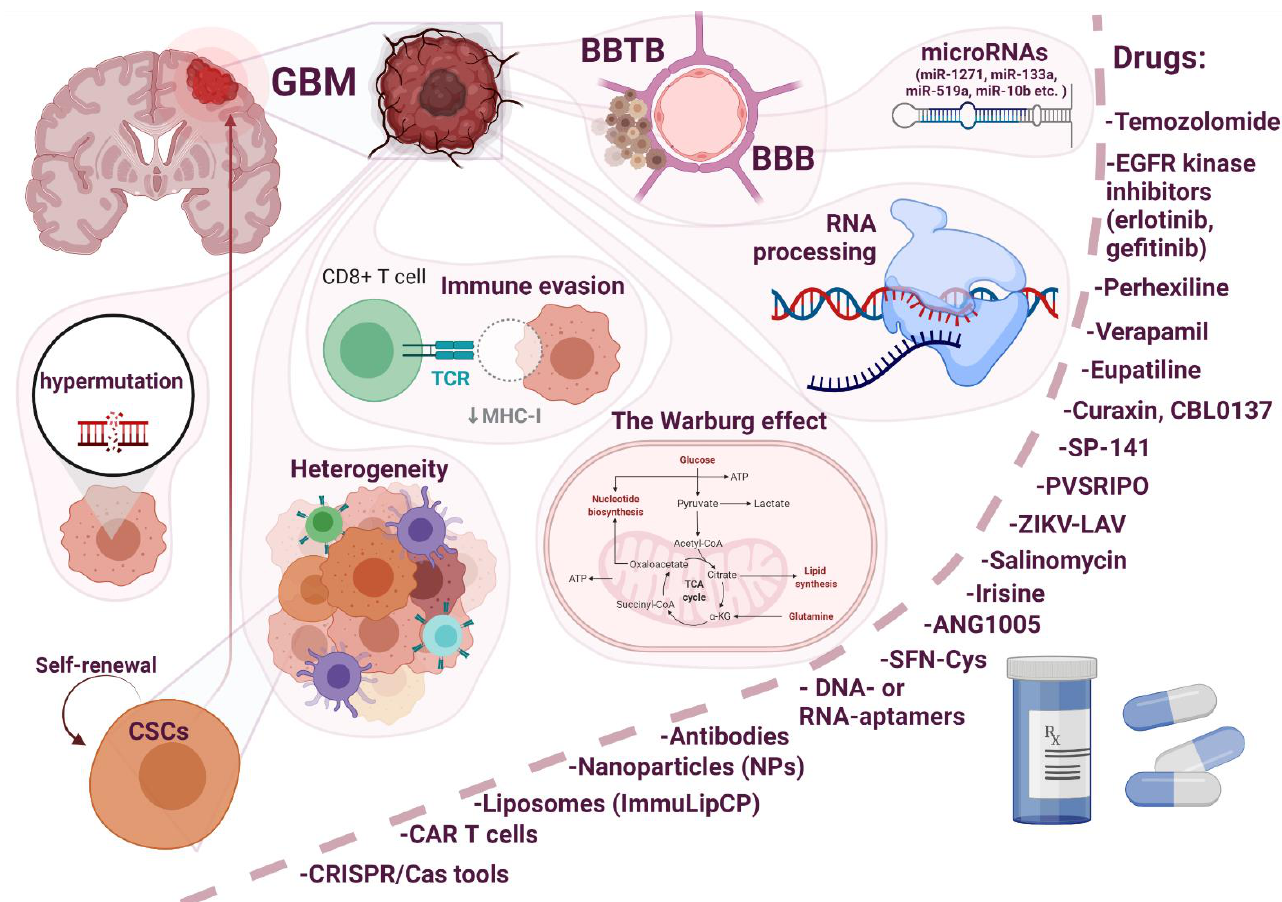
Figure 1. Main issues related to the development of drug resistance in glioblastoma multiforme (GBM).